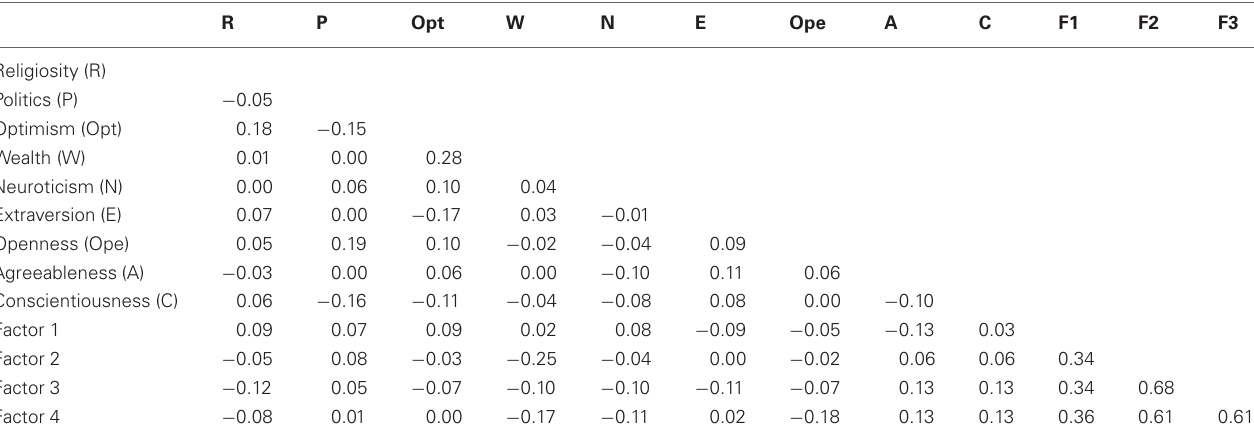
Table 2 | Correlations between beliefs, personality and the